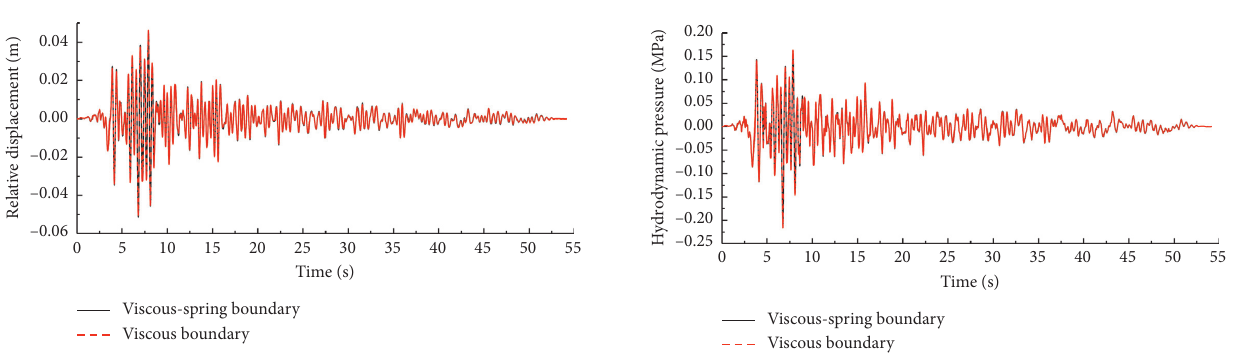
Figure 11: Time histories of hydrodynamic pressure of the Pine Flat dam at dam dam heel are − 15.24 cm and − 14.93 cm, and the maximum vertical displacements at dam heel are − 10.98 cm and − 10.88 cm, respectively. The absolute values of the relative error are 0.95%, 0.23%, 2.04%, and 0.95%, respectively. Time histories of relative horizontal and vertical dis- placements of dam crest and dam heel are plotted in Fig- ure 18. The maximum relative horizontal displacements of dam crest and dam heel are 12.76 cm and 12.96 cm, in which the relative error is 1.58%. The maximum relative horizontal displacements of dam crest and dam heel are 3.42 cm and 3.43 cm, in which the relative error is 0.33%. Time histories of horizontal accelerations at dam crest are shown in Figure 19. For the solutions by using the viscous-spring boundary and viscous boundary, the